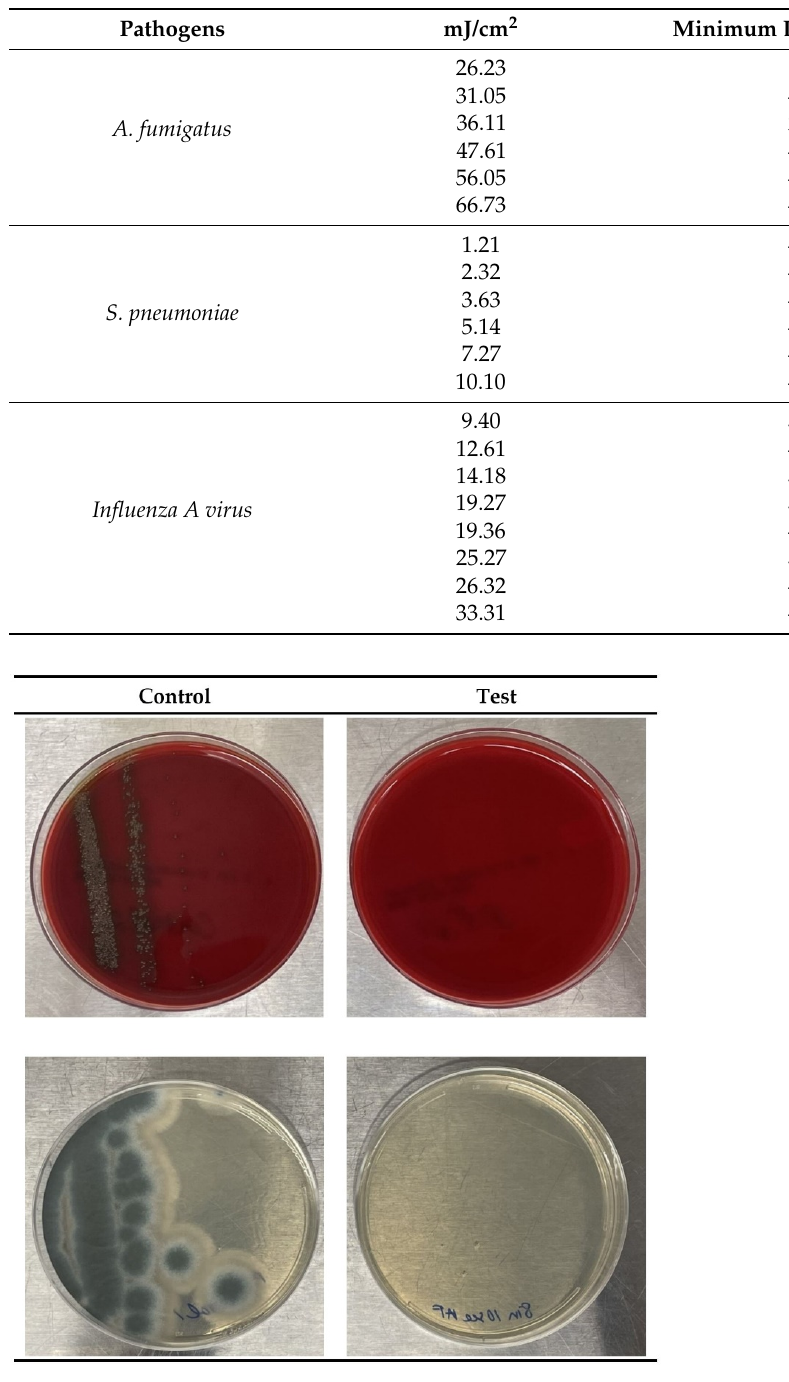
Figure 7. The UVC deactivation results for S. pneumoniae bacteria (top row) and A. fumigatus mold (bottom row) are shown by comparing an unexposed control (left column) and a UVC exposed plate (right column).